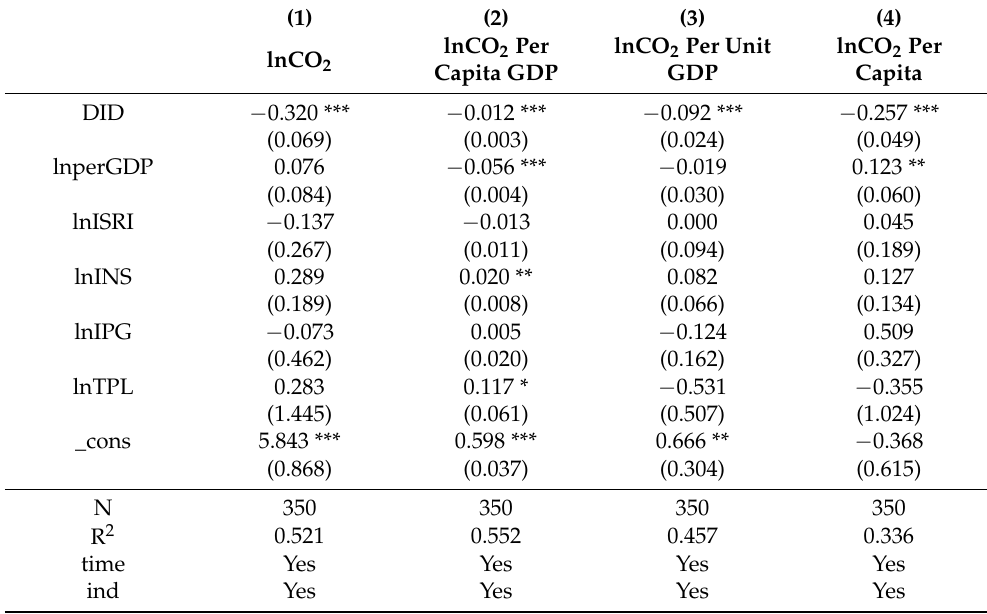
Table 4. Baseline regression of the impact of pollution permit management in key industries on CO 2